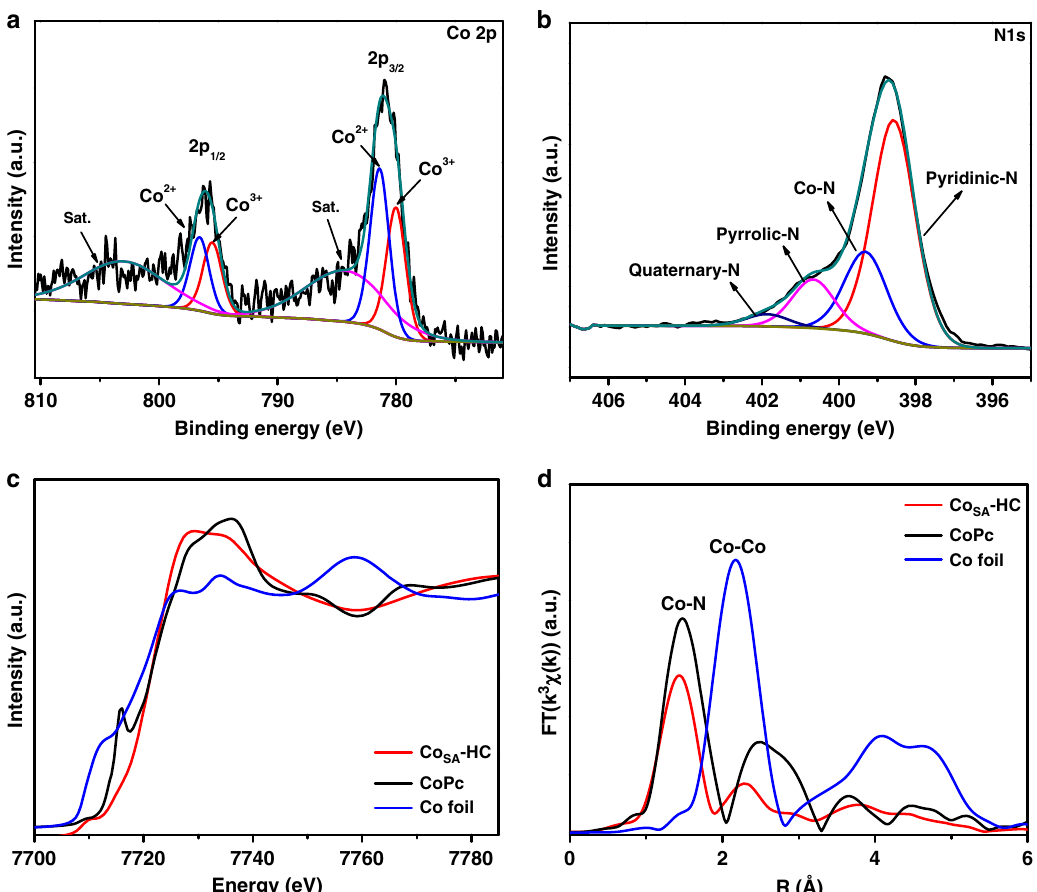
Fig. 3 Structure analysis of the Co SA -HC particles. a Co 2p and b N 1 s XPS spectra of Co SA -HC particles, c Co XANES spectra and d Fourier-transform EXAFS spectra of Co SA -HC, Co foil and Co phthalocyanine